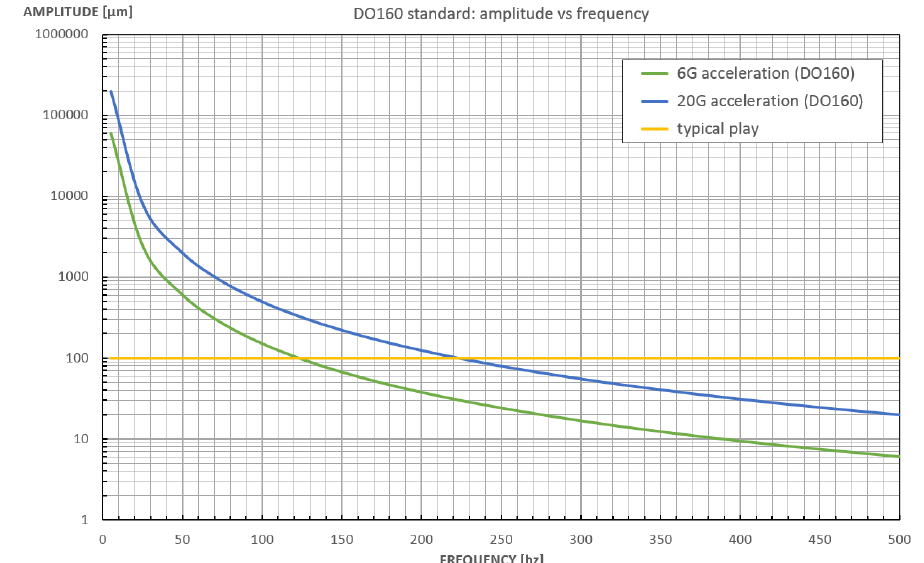
Figure 12. DO–160 accelerations: amplitude evolutions with respect to frequencies.